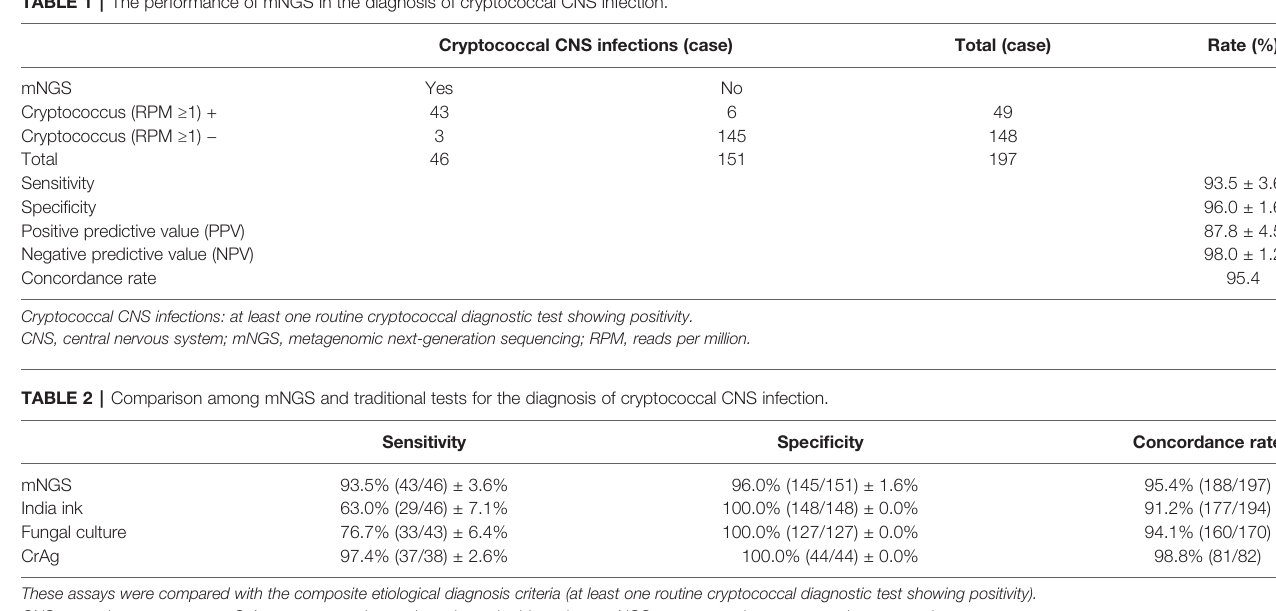
TABLE 1 | The performance of mNGS in the diagnosis of cryptococcal CNS infection.